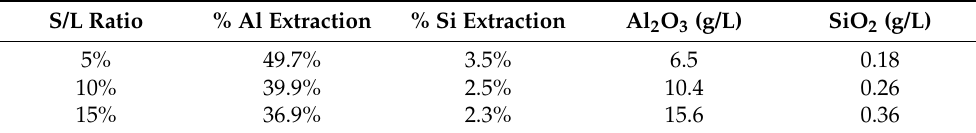
Table 6. Al and Si extraction rates and concentrations in the aluminate solutions at different S/L ratios.